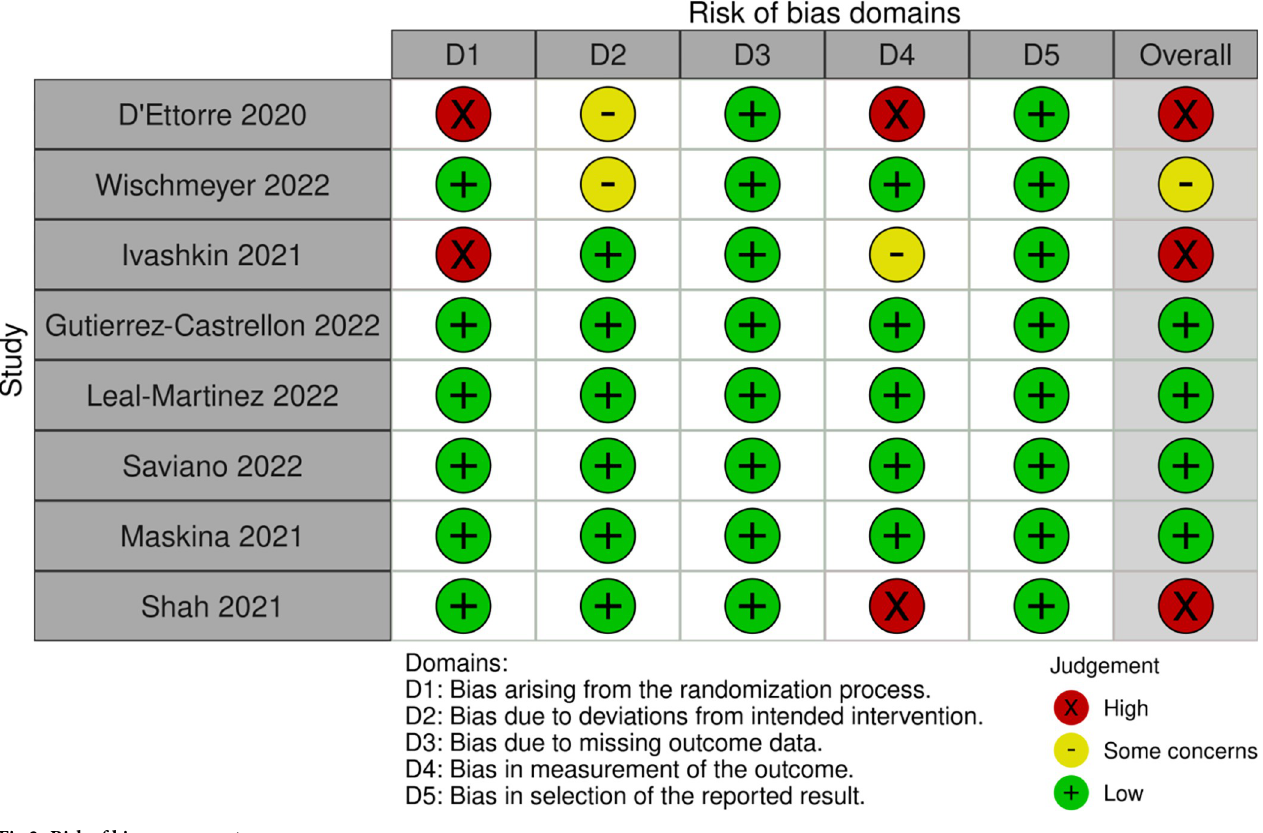
Fig 2. Risk of bias